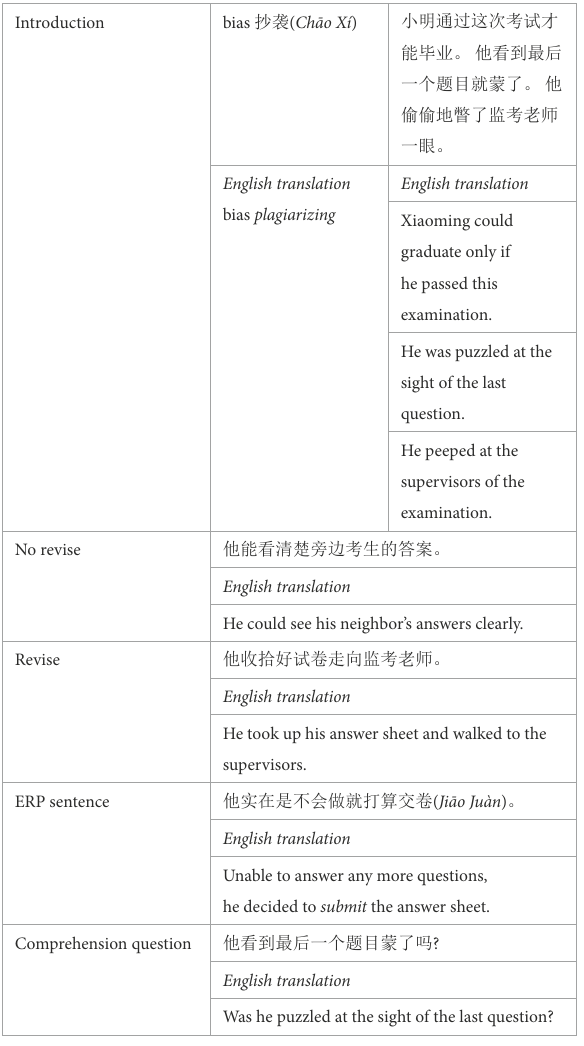
TABLE 3 Sample material used in Experiment